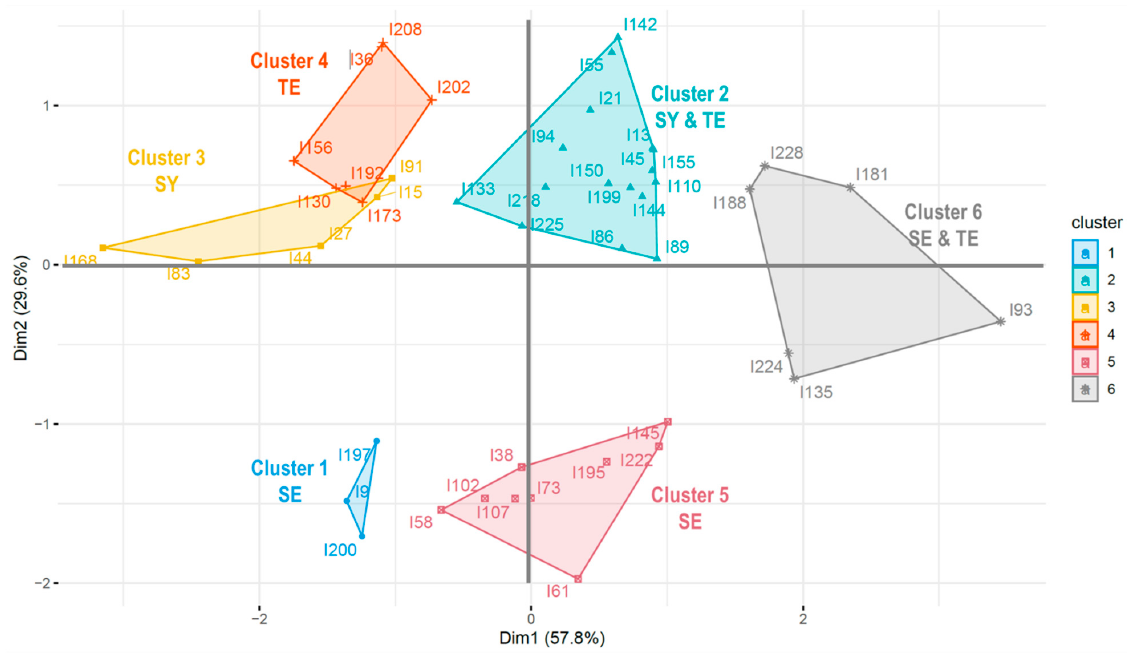
Figure 4. Multiple correspondence analysis results.